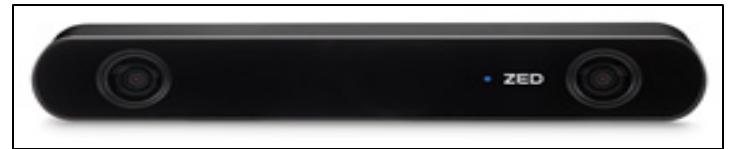
Figure 1. ZED 2i depth sensor (courtesy of Stereolabs) [36].